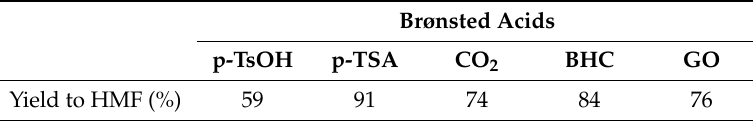
Table 2. Synthesis of HMF in the presence of different Brønsted acids and ChCl-derived LMMs from fructose [18,22–26]. BHC: betaine hydrochloride; GO: graphene oxide nanosheets; p-TSA: p-toluene sulfonic acid monohydrate; p-TsOH: p-toluenesulfonic acid.